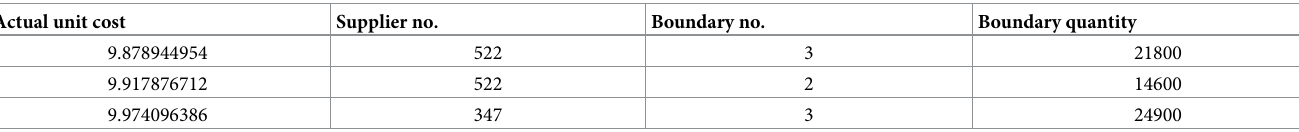
Table 5. List 2 of quantity 24900, Data20. Actual unit